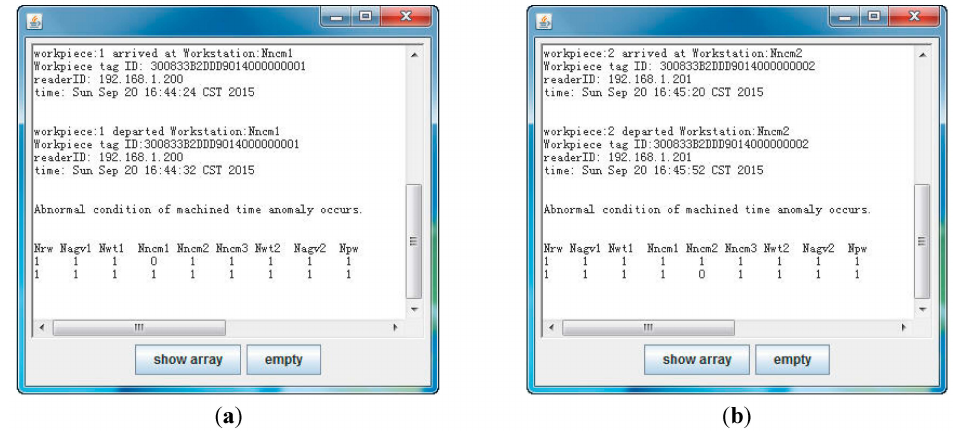
Figure 10. ( a ) Physical experiment result on workstation N ncm 1 ; ( b ) Physical experiment result on workstation N ncm 2